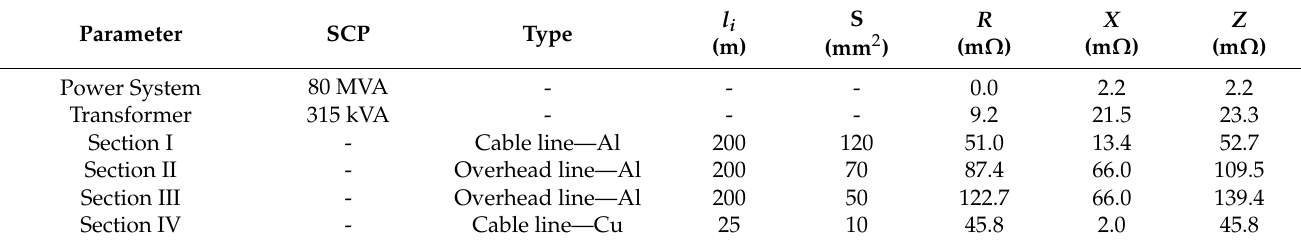
Table 1. Parameters of selected low-voltage power grid configurations with radial topology—Line 1.